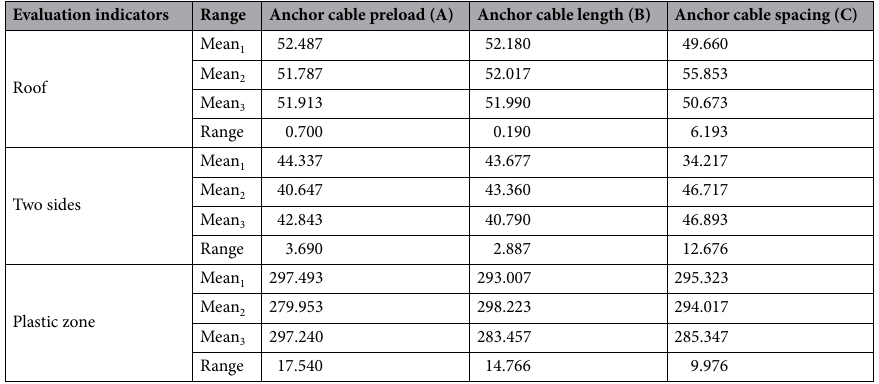
Table 5. Mean and range results of each evaluation indicators.